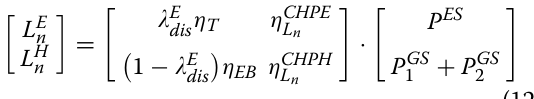
loads ( N = 1, 2, 3 ) are presented with the 8-node gas network structure of Fig. 2. Three types of energy are involved in this multi-energy system, i.e., thermal, natu - ral gas and electric. The electric load is supplied by the external power grid and CHP units of the respective load groups, while the thermal load is supplied by the electric boiler and CHP units of the respective load groups. The input and output model of the energy hub is given as: